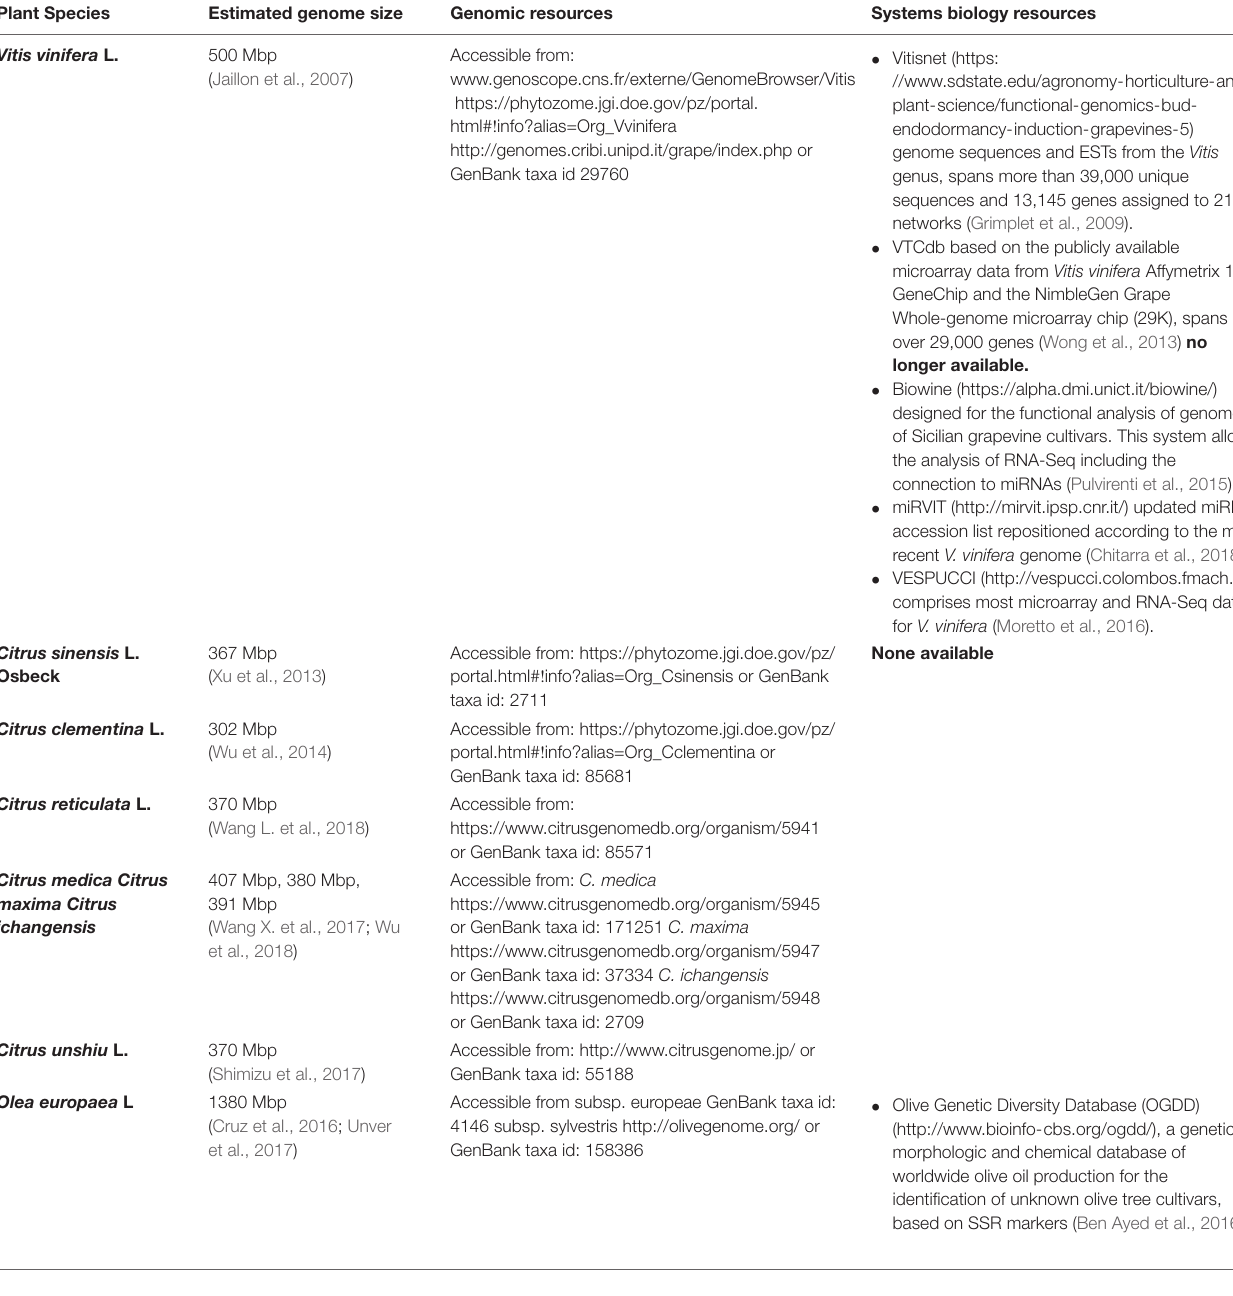
TABLE 1 | Main grapevine, citrus and olive species already sequenced including working URLs with access to JBrowse, BLAST search and multiple sequence alignment tools and availability of systems biology tools with currently workingURLs. Plant Species Estimated genome